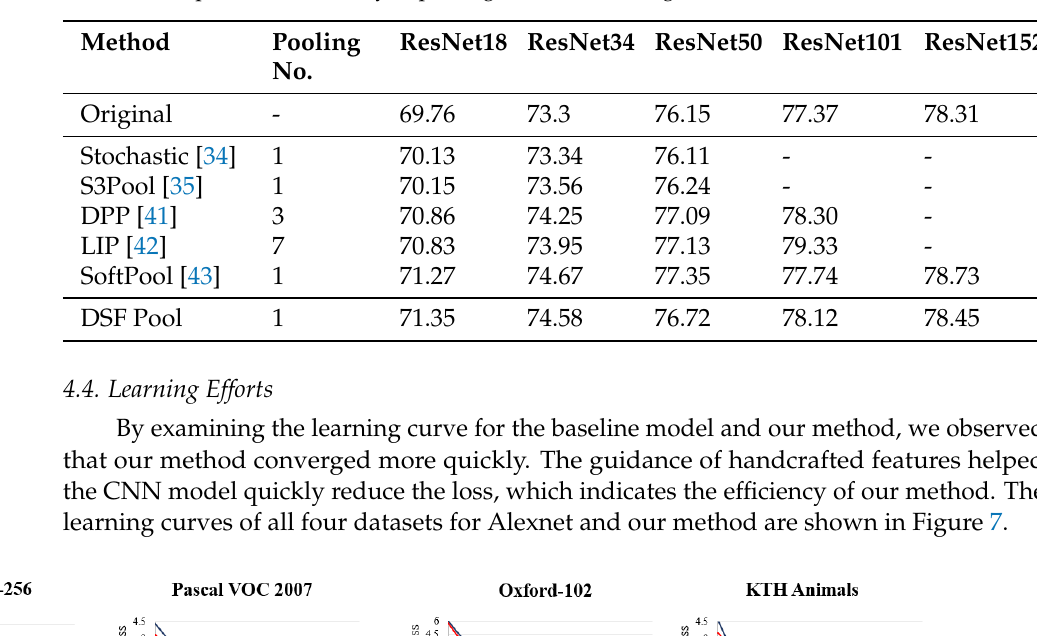
Table 7. Comparison of a variety of pooling methods on Imagenet1K for the classification task.